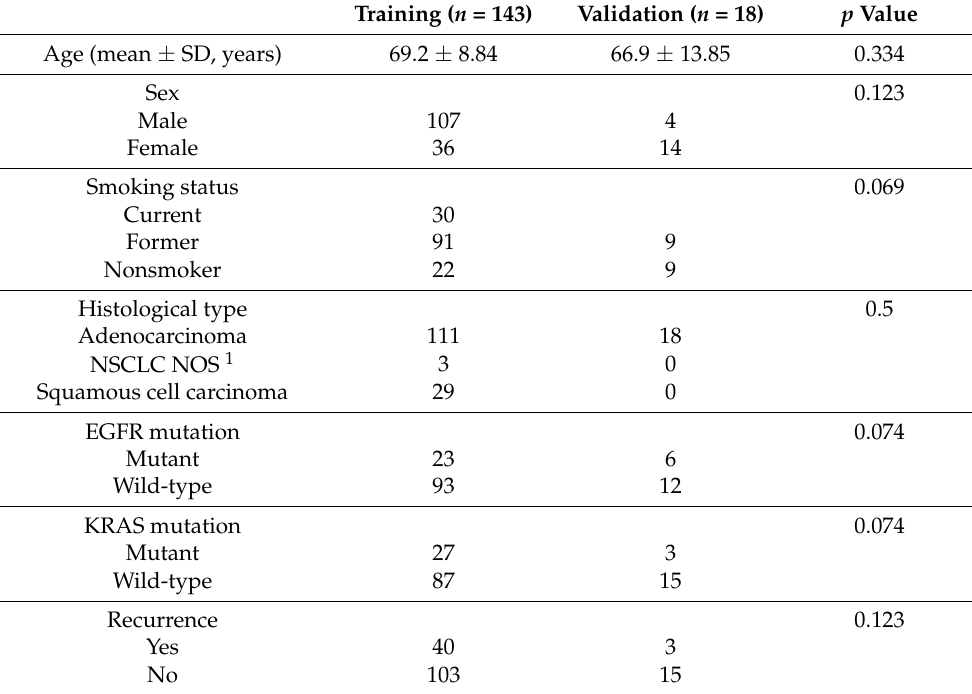
Table 1. Characteristics of patients in our cohorts.